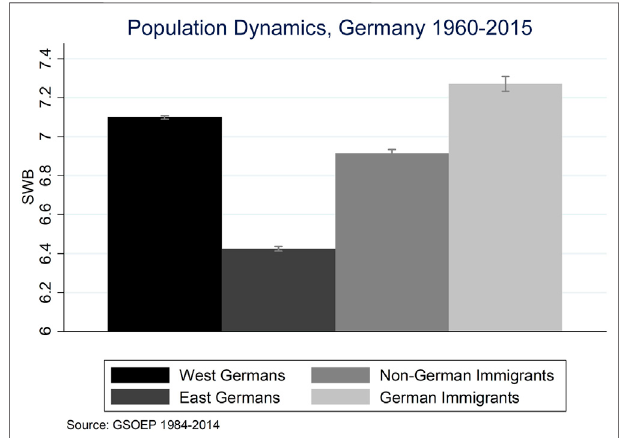
FIGURE 2 | Population Dynamics, Germany 1960 – 2015